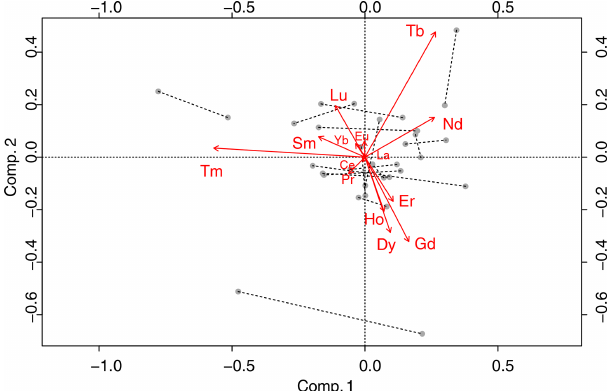
Figure F1. REE biplot for two VTD simulation results. Percentages of variability explained by the first two components are 27% and 19%, a total of